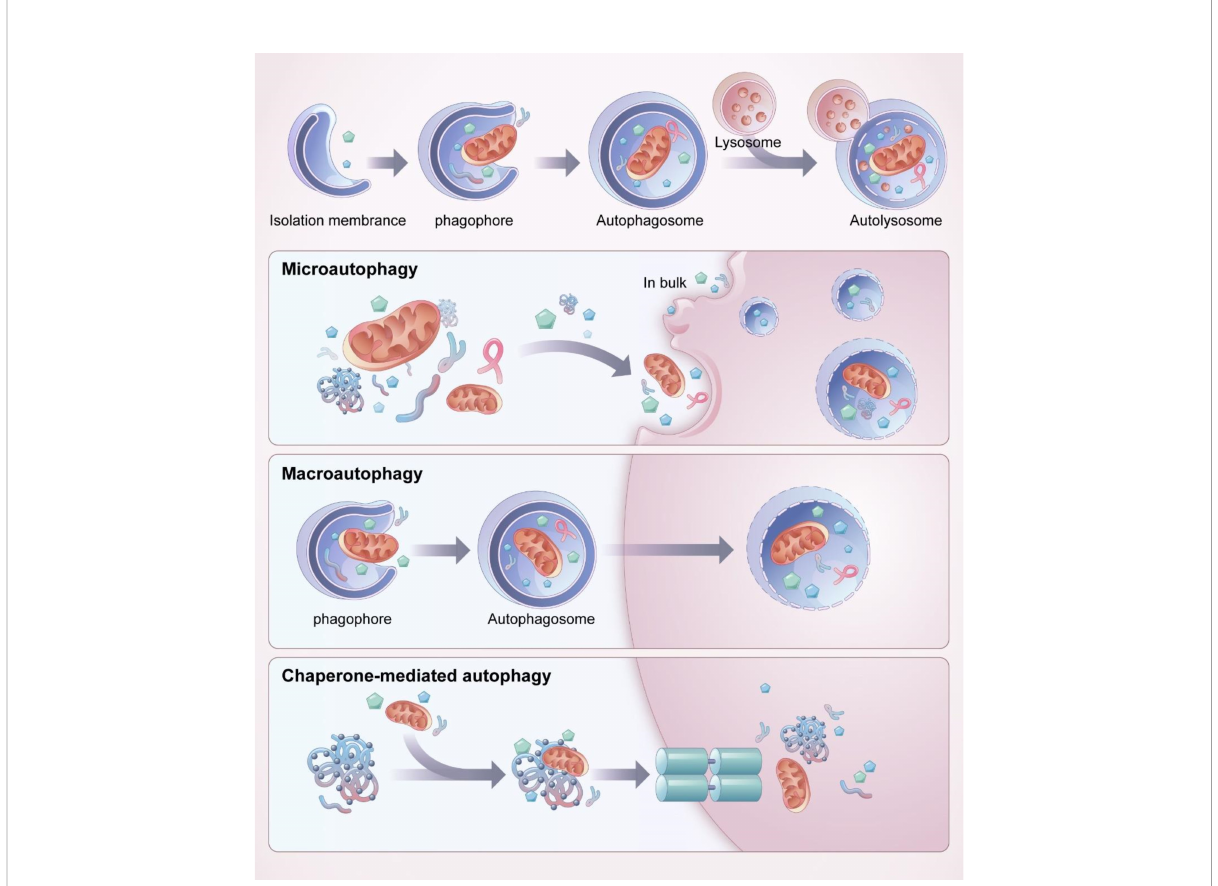
FIGURE 2 Process and classi fi cation of autophagy. Mitochondria and other organelles in the cytoplasm are fi rstly encapsulated by vesicles called “ isolation membranes ” , which gradually close to form a bilayer membrane structure, namely autophagosome. The outer membrane of autophagosome fuses with lysosome to form autolysosome, the contents and intima of autolysosome are degraded by enzymes in lysosomes. There are three main forms of autophagy, chaperone-mediated autophagy, microautophagy and macroautophagy, among which macroautophagy is the most common. Microautophagy directly wraps the substrate to be degraded into the lysosome for degradation through invagination or protrusion of the lysosomal membrane. In chaperone-mediated autophagy, a speci fi c protein is involved, and the molecular chaperone recognizes the target protein through a speci fi c structural domain and transports it into the lysosome for degradation. In macroautophagy, the autophaosome is required to wrap the substrate to be